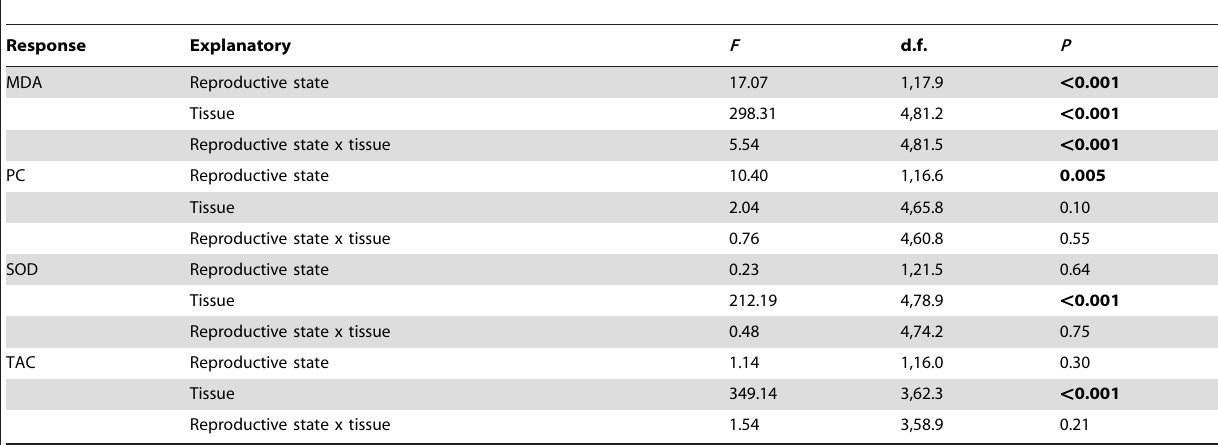
Table 1. Variation in markers of oxidative damage (MDA and PC) and antioxidant defence (TAC and SOD) in relation to reproductive state and